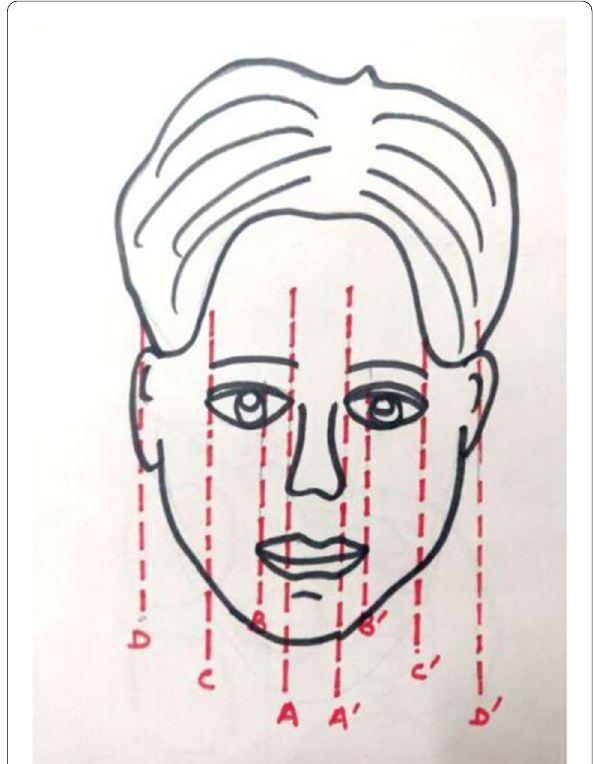
Fig. 6 Measure for transverse symmetry Rule of 5 medial (A-C, A’-C’), and lateral (C-D, C’-D’) fifths are equal in a proportioned face (Premkumar